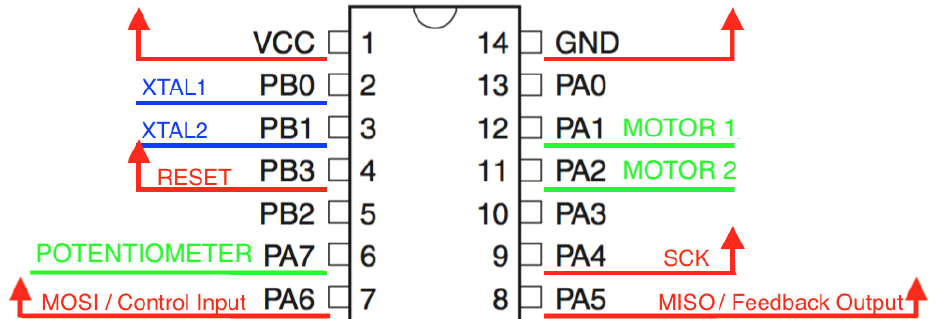
Figure 4. Connection diagram of the microcontroller ATTiny84. Internal connections (motor driver and potentiometer pinout) are marked in green. Cristal pinout is marked in blue. External pinouts for programming and power are marked in red. MOSI pin works as the control pin and MISO pin works as the feedback pin.